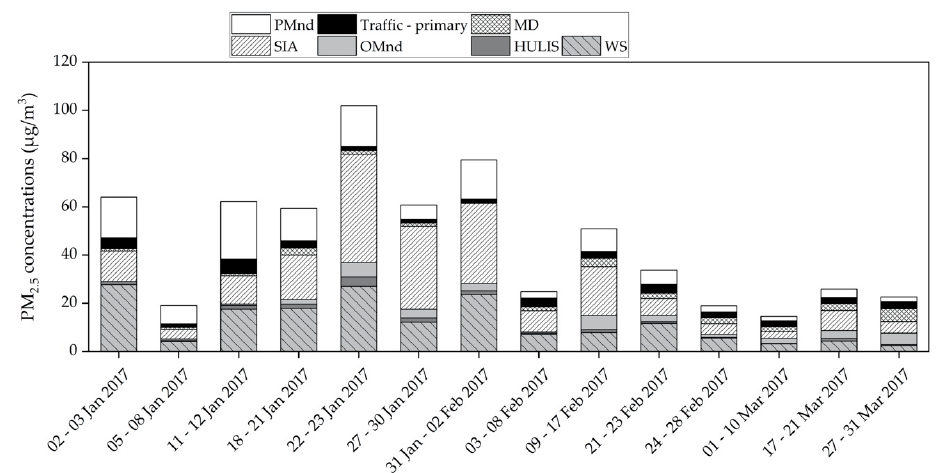
Figure 9. Average mass concentrations of PM 2.5 source groups and undefined PM assigned by the macro-tracer method. Abbreviations: PMnd = PM not defined, MD = mineral dust, SIA = secondary inorganic aerosols, OMnd = organic material not defined, WS = wood smoke